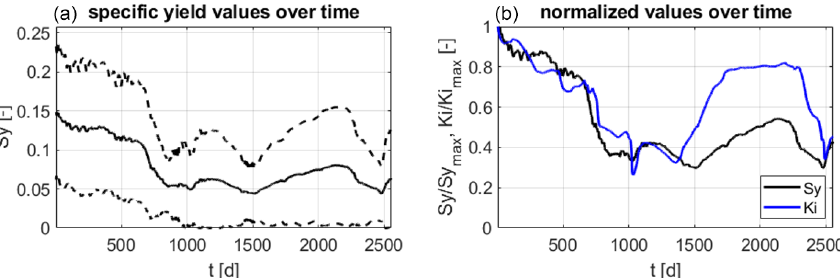
Figure 15. (a) Specific yield values resulting from the iterative coupling for the 3D flow problem. The solid line is the spatial average; the dashed lines indicate ± 1 standard deviation. (b) Normalized specific yield and saturated hydraulic conductivity at the water table position over time.